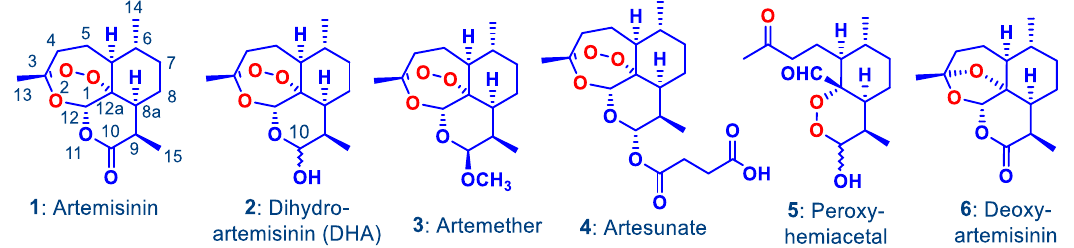
Figure 1. Artemisinin 1 and its clinically-used derivatives—the hemiacetal dihydroartemisinin (DHA) 2 , the lactol ether artemether 3 , and the hemiester artesunate 4 . The latter two are rapidly converted into DHA via metabolism or facile hydrolysis respectively. DHA rearranges irreversibly under physiological conditions into the peroxyhemiacetal 5 that in turn rearranges to the inert deoxyartemisinin 6 .